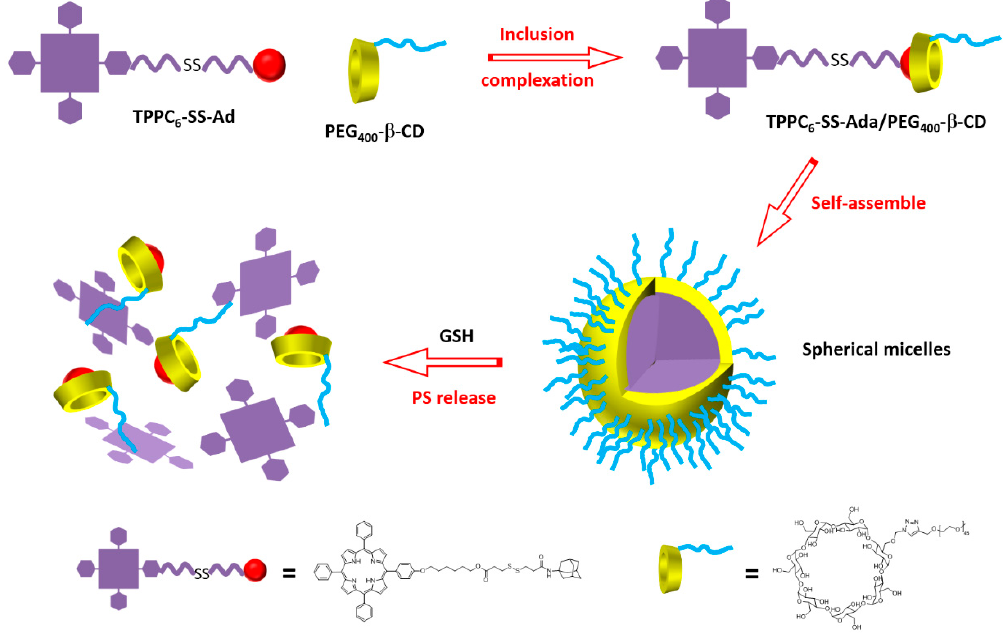
Figure 50. Self-assembly and disaggregation process of TPPC 6 -SS-Ada/PEG 400 - β -CD micelles. Adapted from Liu; Ma; Xu; Liu; Zhang [181].